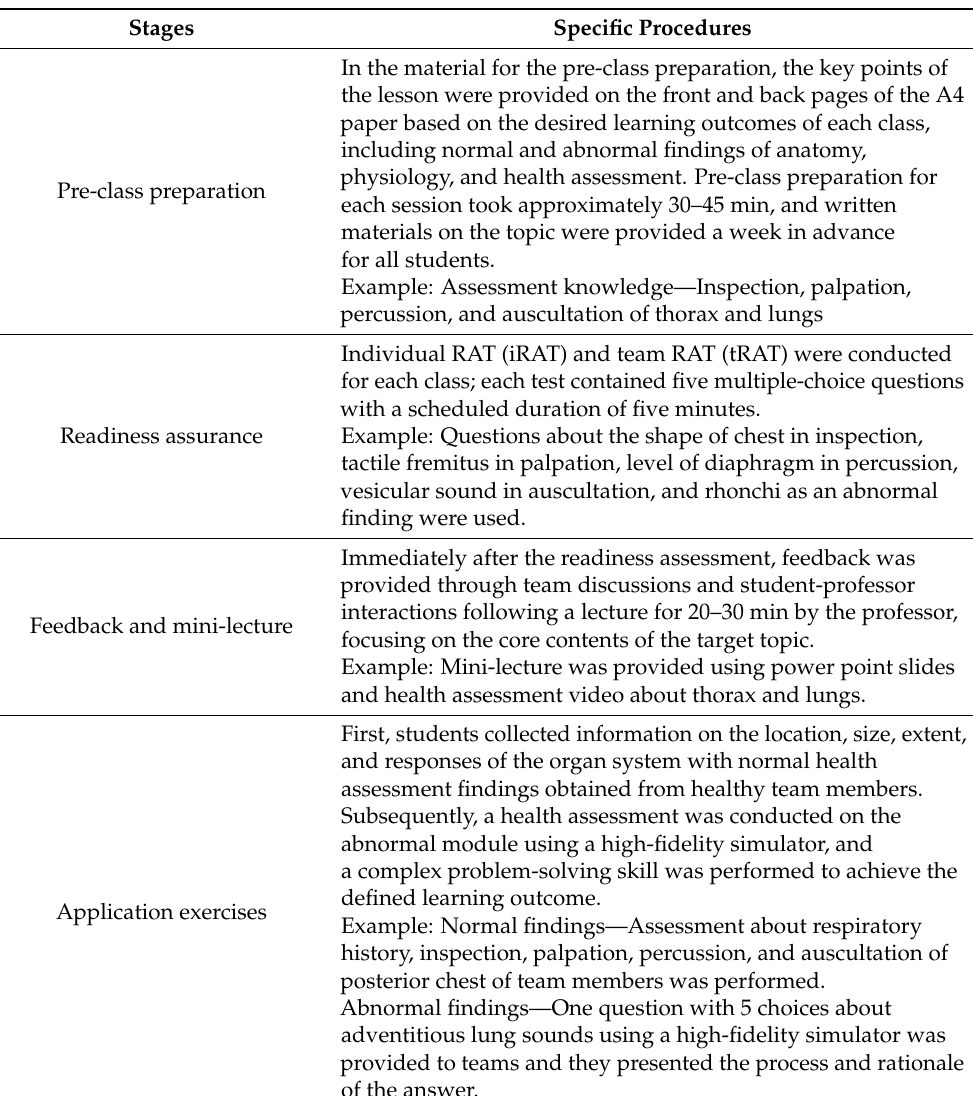
Table 1. Stage-specific procedures of team-based learning applied to the respiratory